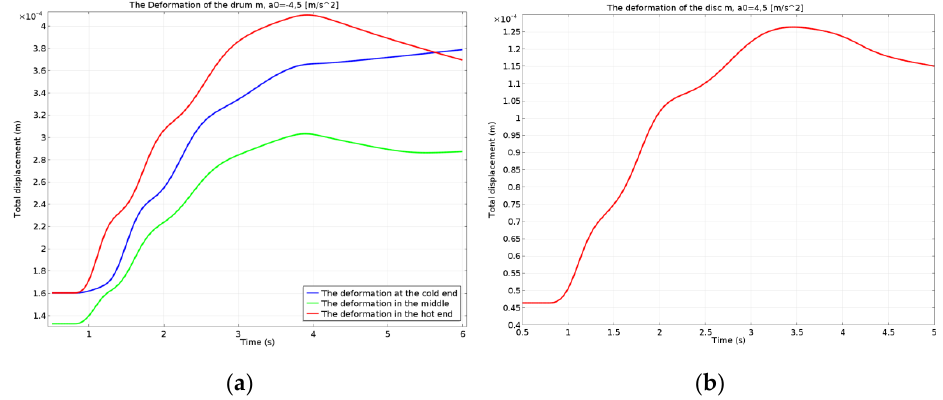
Figure 30. Deformation variation in time for: ( a ) drum-and-shoe system; ( b ) disc-and-pads system.